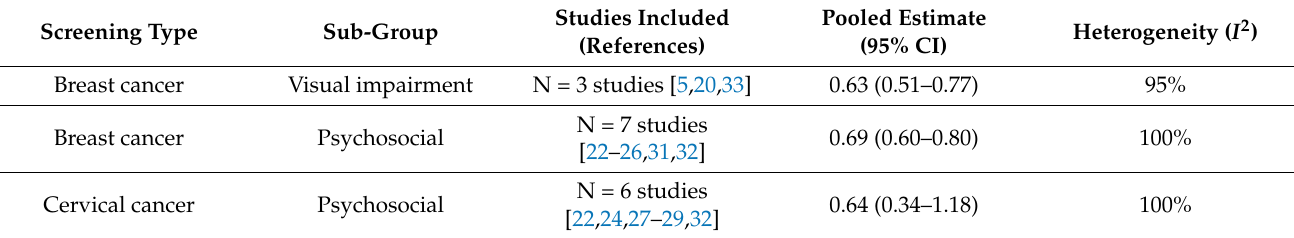
Table 4. Summary of subgroup